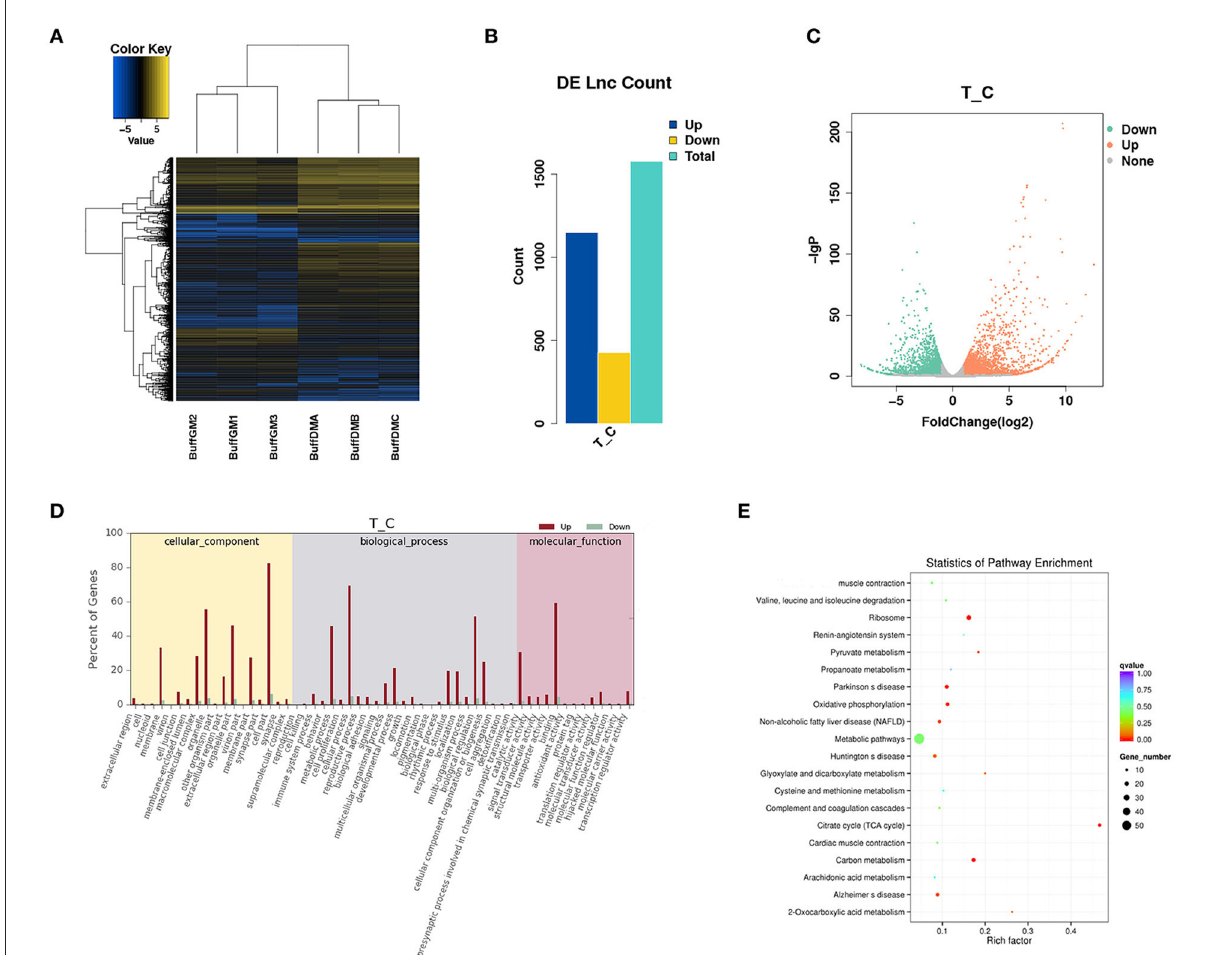
FIGURE3 Differentially expressed lncRNAs in proliferating and differentiating buffalo myoblasts. (A–C) A heatmap, histogram and volcano plots of thedifferentially expressed lncRNAs in proliferating and differentiating buffalo myoblasts. (D,E) The enriched GO terms and KEGG pathways are shown. BuffGM represents buffalo muscle cells at the proliferative phase and BuffDM represents buffalo muscle cells at the differentiation